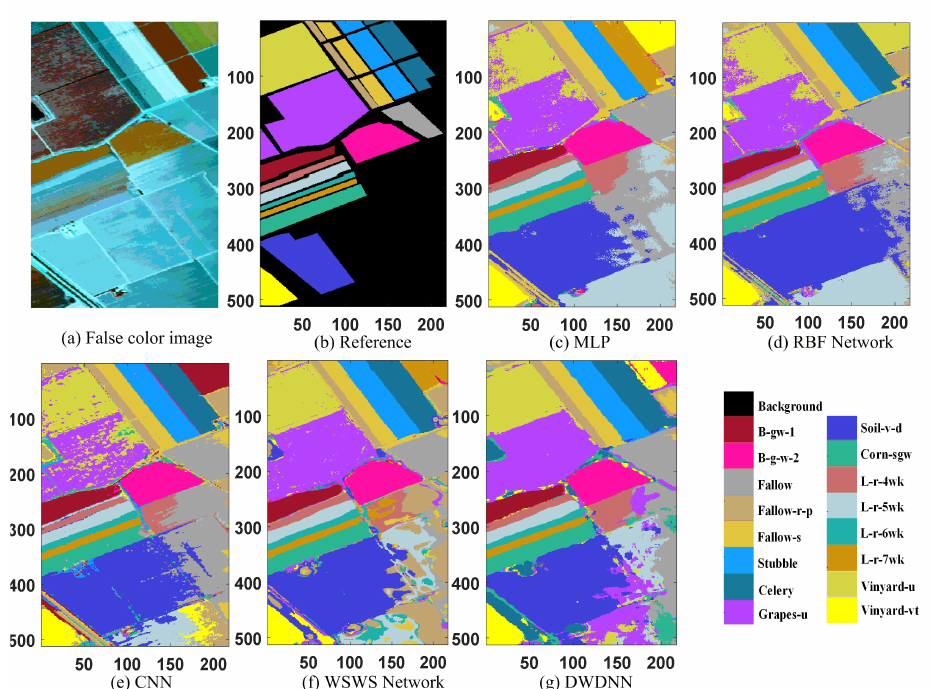
Figure 7. Classification results of the Salinas dataset (the instances without class information were also predicted). ( a ) false color image, ( b ) Reference image, ( c ) MLP, ( d ) RBF Network, ( e ) CNN, ( f ) WSWS Network, and ( g )